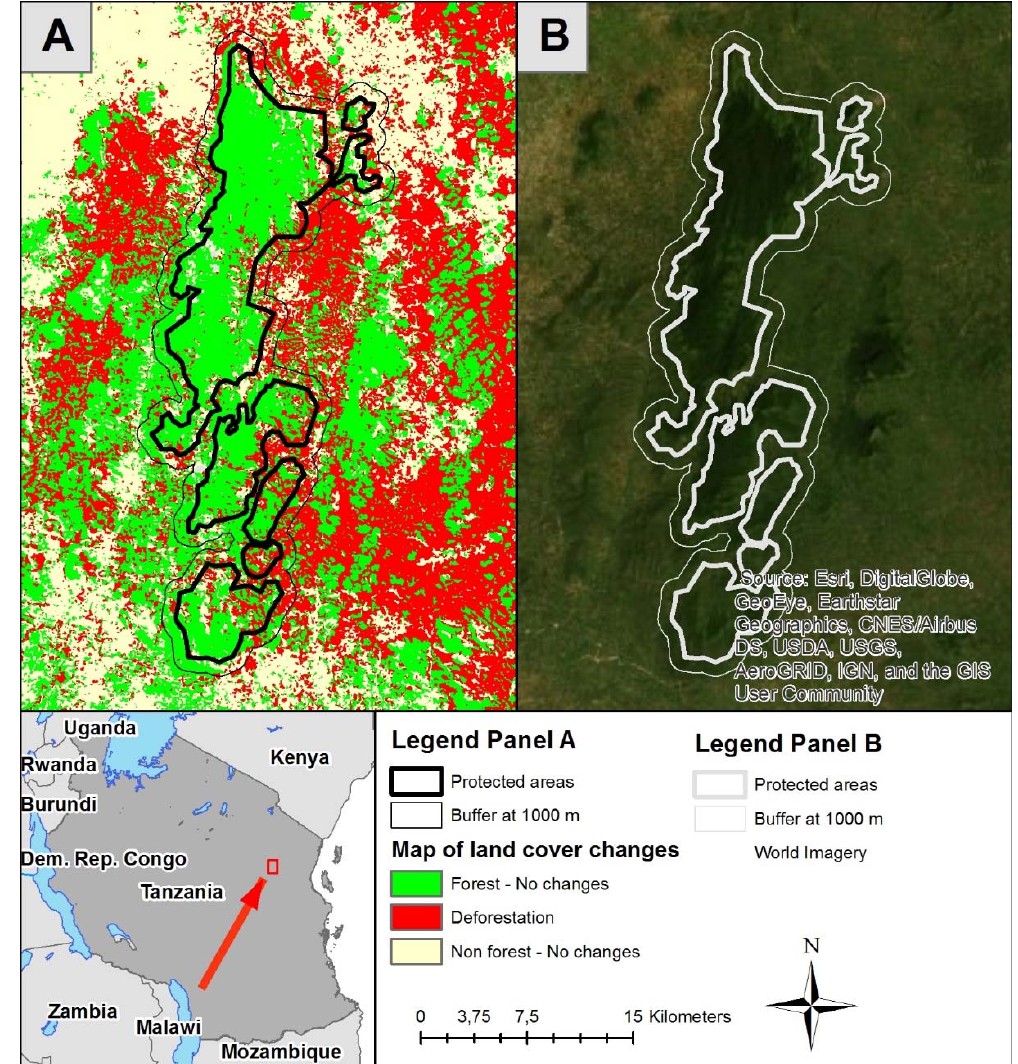
Figure 6. Deforestation inside and the buffer areas of mostly disconnected PAs (Forest Reserves) along the Eastern Arc mountains in Eastern Tanzania. PAs in figure are (North to South): Nguru North, Mamboto, Mkongo, Nderema, Pumula, Mbwegere, and MKuli Forest Reserves. Panel ( A ) is. of this study; and Panel ( B ) is image from space imagery providers.